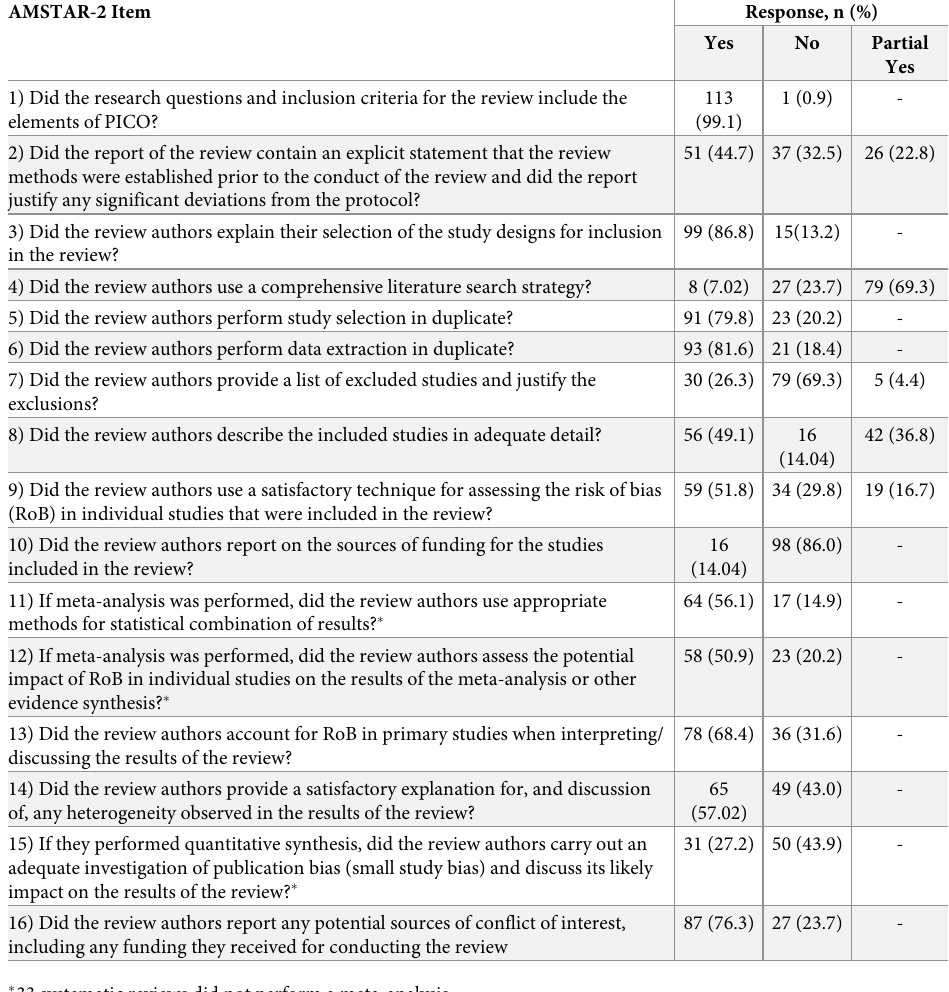
Table 3. AMSTAR-2 items and frequency of responses. AMSTAR-2 Item Response, n (%)